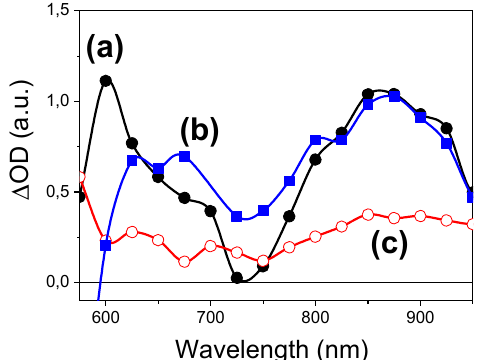
Figure 7. Transient spectra recorded at 100 µ s after 532 nm laser excitation of a N 2 purged film of MA 2 CuCl 2 Br 2 ( a ) and after exposure to methanol ( b ) or oxygen ( c ).